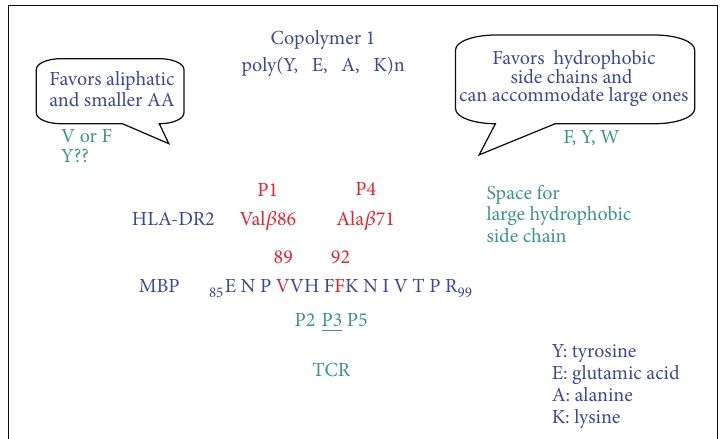
Figure 1: Schematic representation of the rational for design of the novel copolymer